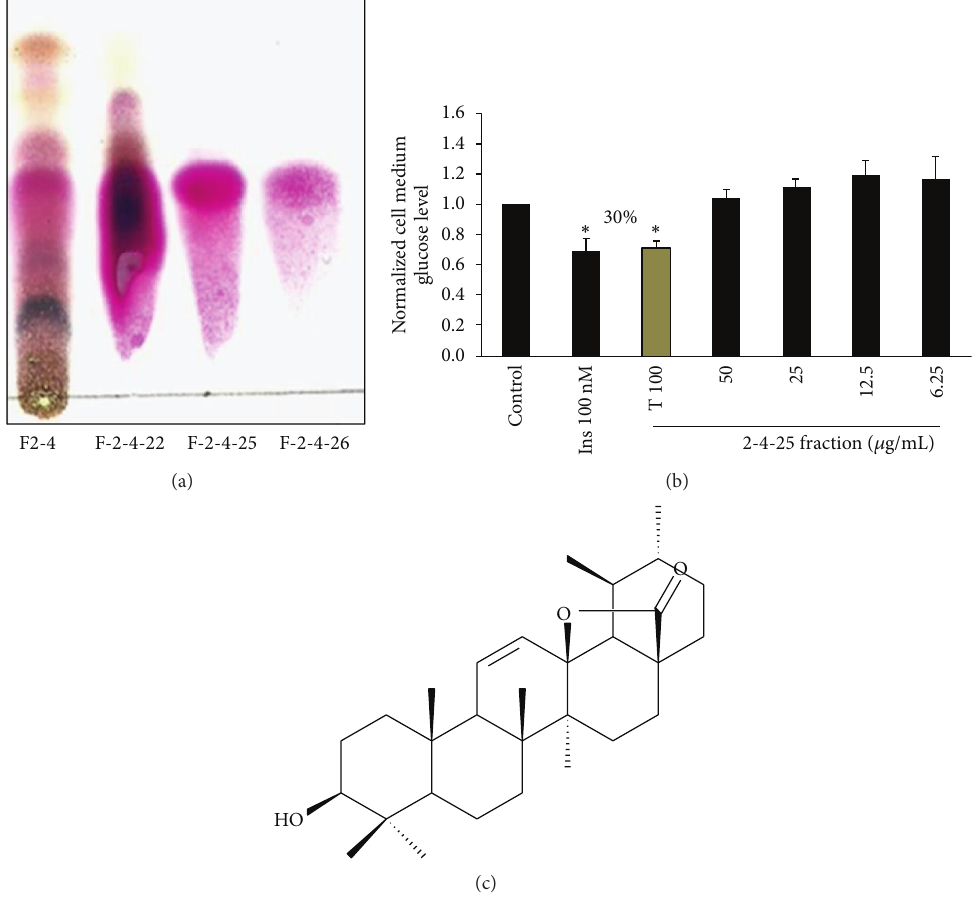
Figure 5: Effect of the fraction 2-4-25 enriched in compound 1 on glucose uptake in C2C12 cells. (a) Thin-layer chromatography. Fraction F2- 4 was separated again on a silica gel column. Subfraction 22 shows a large amount of triterpenes; pure compound 1 obtained from subfractions 25 and 26 after TLC. (b) 2-4-25 fraction rich in compound 1 increases glucose uptake. 𝑛 = 3 . ∗ 𝑝 < 0.05 versus control, Student t -test. (c) Structure of compound 1 : 3 𝛽 -hydroxy-urs-11-en-28,13 𝛽